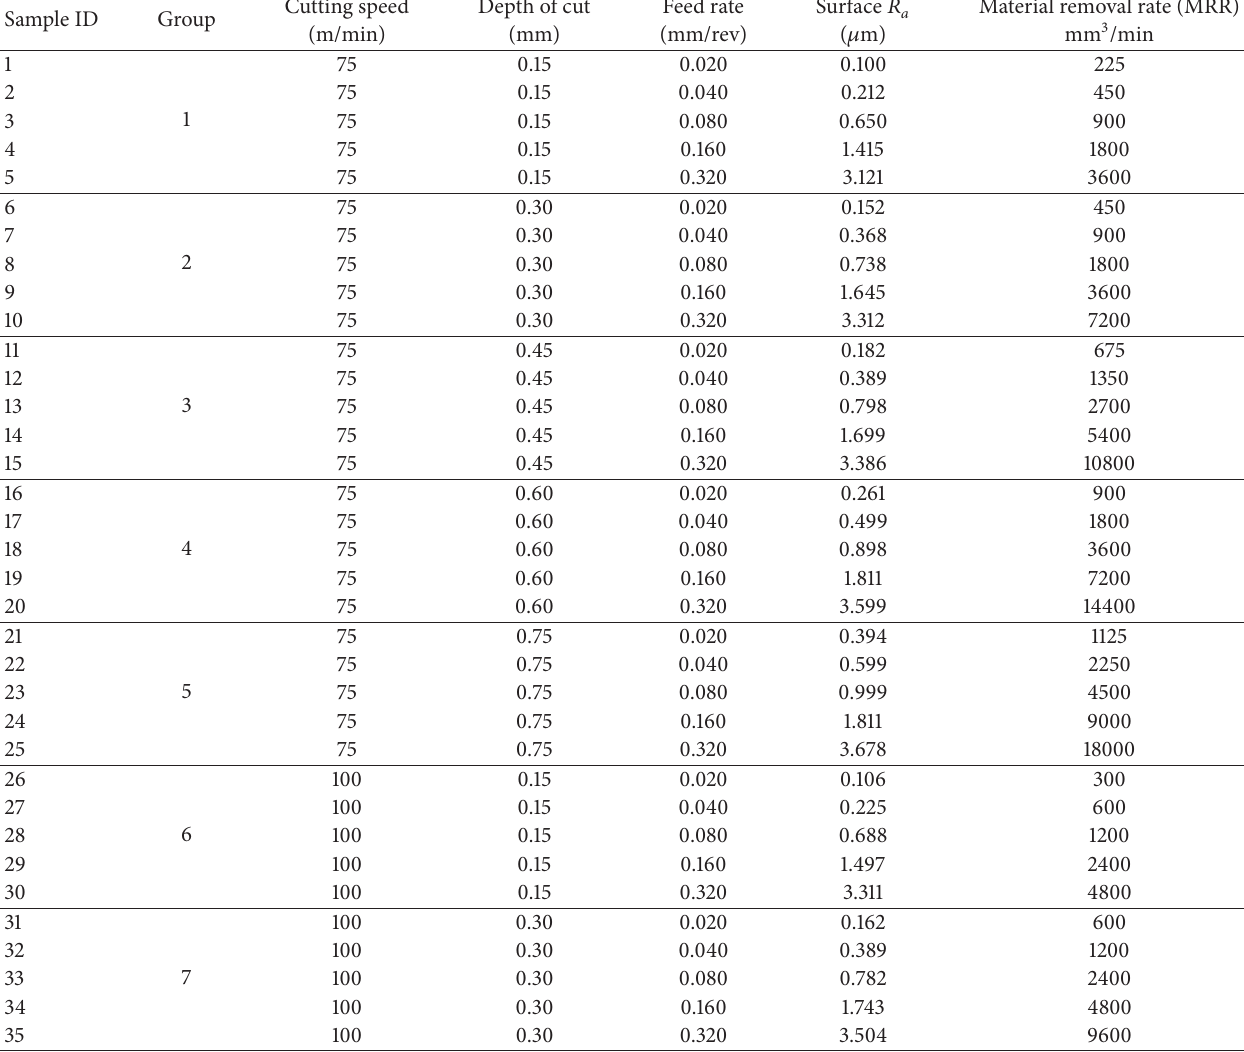
Table 7: Full listing of experimental